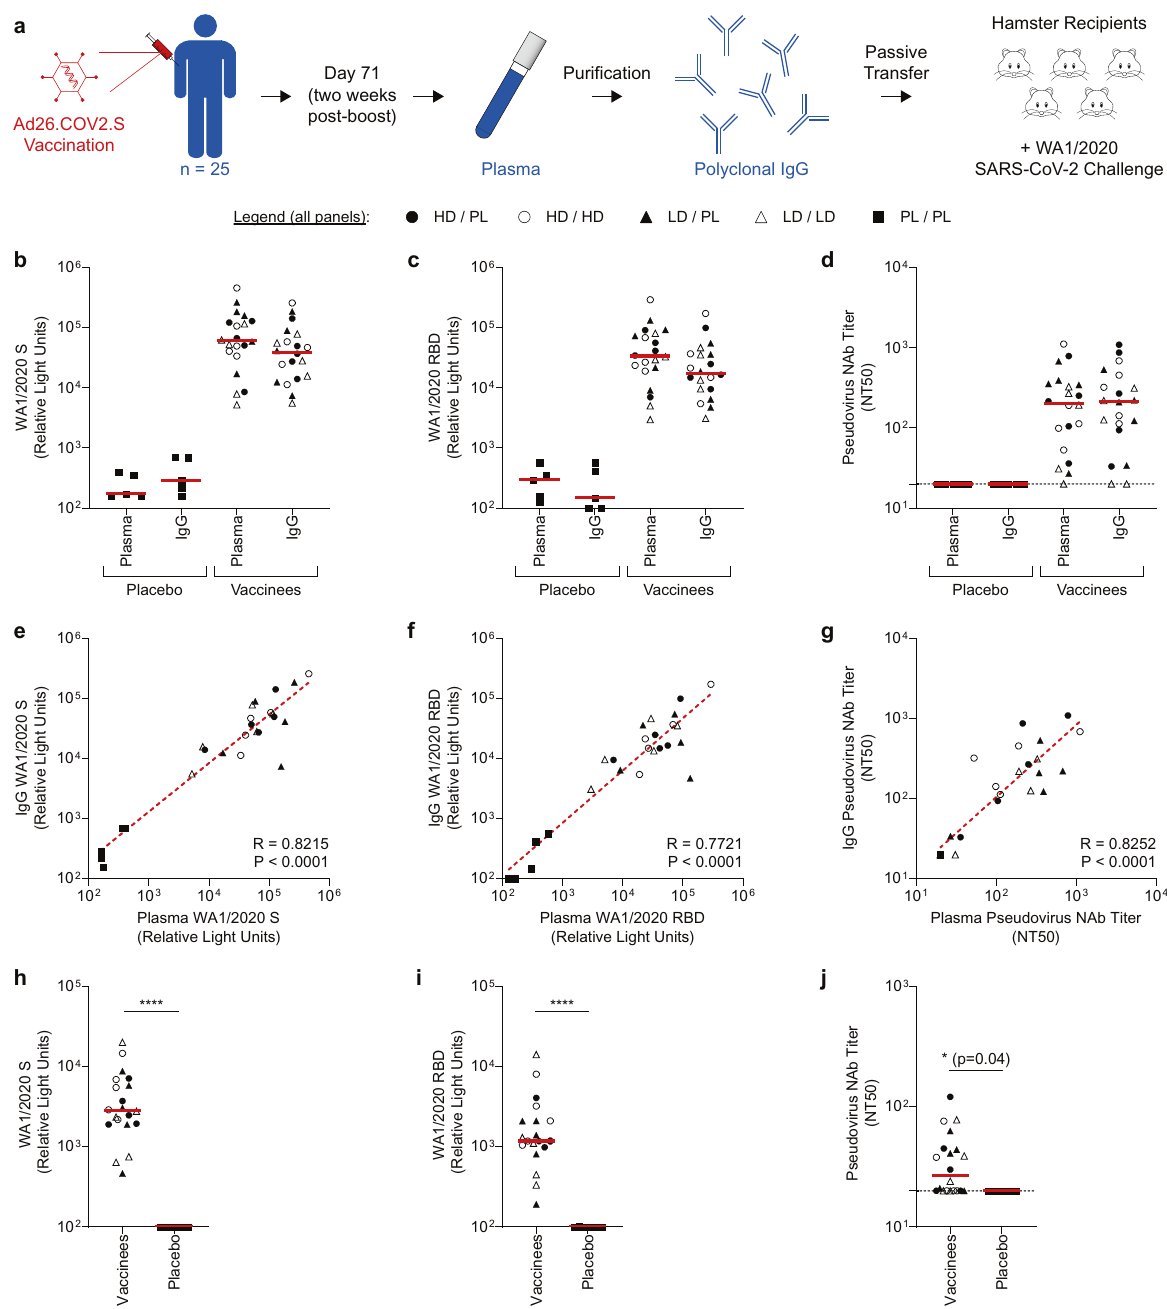
Fig. 1 Ad26.COV2.S vaccine elicits binding and neutralizing antibodies in plasma and puri fi ed IgG from human vaccine recipients. a Schematic of the experimental design. Particpants in the COV1001 clinical trial were vaccinated with Ad26.COV2.S or placebo control. On day 71, plasma samples were collected and total IgG was puri fi ed. IgG was then transferred into naïve hamster recipients, followed by intra-nasal challenge with WA1/2020 SARS-CoV-2. b – d Binding and neutralizing activity was quanti fi ed in human plasma samples and corresponding IgG puri fi ed from plasma samples from either placebo recipients ( N = 5) or recipients of the Ad26.COV2.S vaccine at the indicated dosing regimens ( N = 20). Binding antibody responses were quanti fi ed via electrochemiluminescent assay (ECLA) speci fi c for ( b ) WA1/2020 SARS-CoV- 2 spike (S) protein and ( c ) WA1/2020 SARS-CoV-2 receptor binding domain (RBD) protein. d Similarly, neutralizing antibody titers were quanti fi ed using a pseudovirus neutralization assay. Data displated indicate the 50% neutralization titer (NT50) of a WA1/2020 SARS-CoV-2 S-expressing pseudovirus. In panels a-c, each data point displayed corresponds to one clinical trial study participant and red lines indicate the group medians. e – g Correlation of ( e ) S binding, ( f ) RBD binding, and ( g ) pseudovirus neutralizing antibody titers in pre-puri fi cation human plasma and corresponding puri fi ed IgG. Each data point displayed corresponds to one study participant. Statistics indicate the results of Spearman correlation analysis. h – j Puri fi ed IgG from vaccinees or placebo recipients was transferred to groups of naïve hamsters ( n = 4 – 5 hamsters/study participant) via intraperitoneal injection. One day post-transfer, hamster serum was collected and analyzed for ( h ) S binding, ( i ) RBD binding, or ( j ) pseudovirus neutralizing antibody titers. Data points displayed in panels h – j correspond to the median titer of each group of n = 4 – 5 hamsters that corresponds to one clinical trial study participant. Horizontal red lines indicate medians of groups corresponding to vaccinees or placebo recipients. Statistics displayed are the results of two-sided Mann – Whitney tests. (**** P ≤